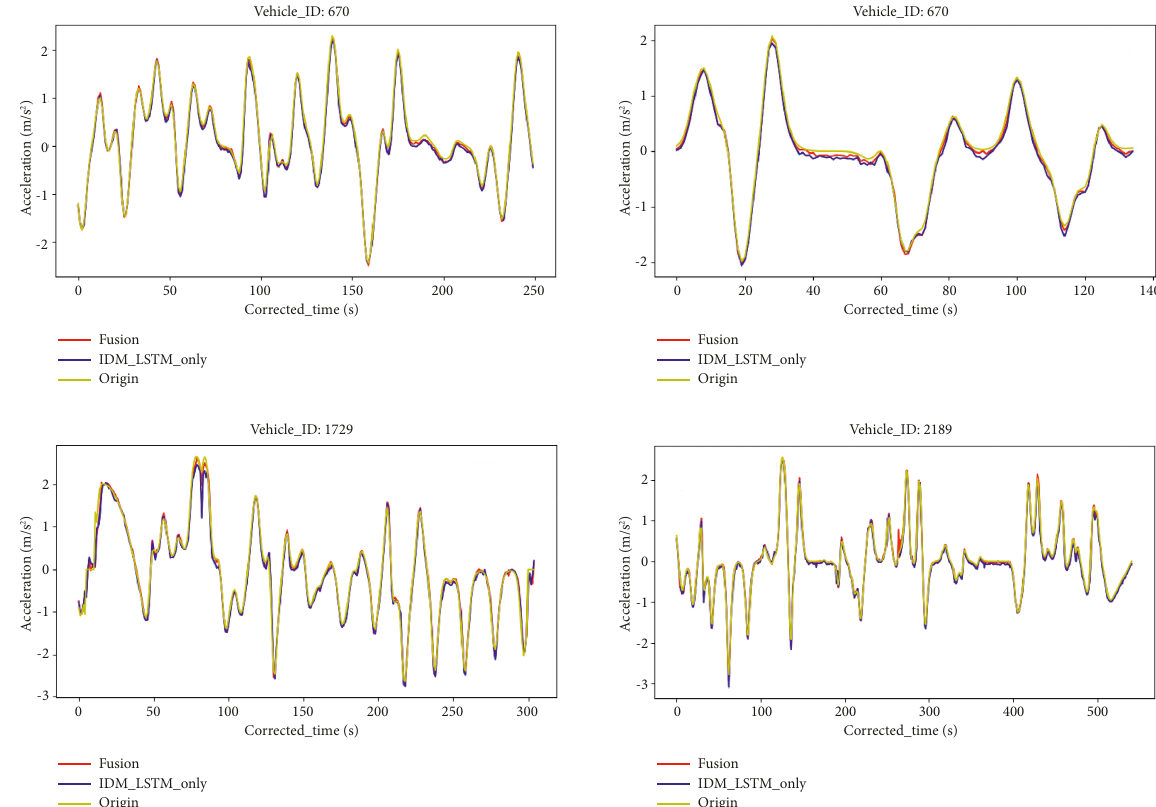
Figure 11: More examples of comparisons of the IDM-informed LSTM and the fusion model (vehicle_ID: